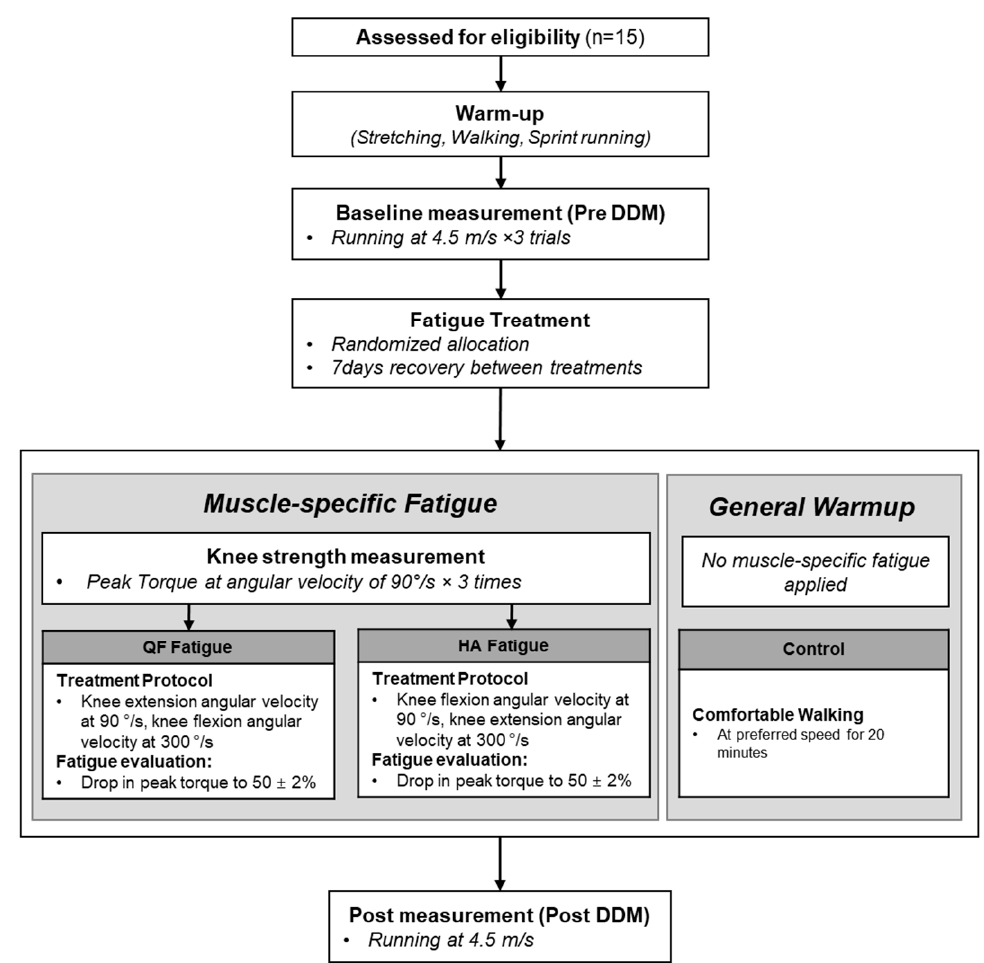
Figure 1. Experimental protocol. (1) Warm-up, (2) baseline measurement: running with DDM at 4.5 m/s, (3) treatment (muscle specific: (i) knee strength measurement; (ii) fatigue treatment; (iii) fatigue evaluation) (general fatigue: walking at preferred speed); (4) post-measurement: running with DDM at 4.5 m/s. The order of the test (control vs. quadriceps fatigue (QF) vs. hamstring (HA) fatigue) was randomized with at least 7 days interval between each condition.